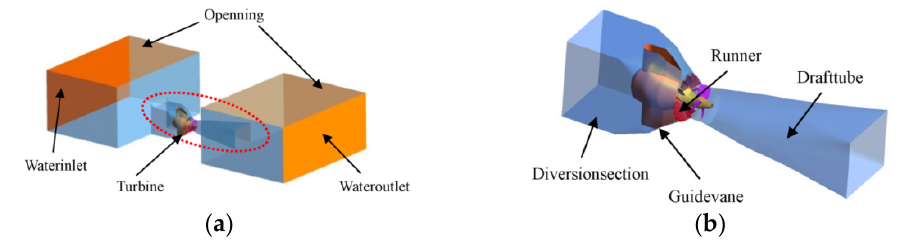
Figure 1. Watershed geometric model: ( a ) Computational domain; ( b ) Schematic of the turbine.